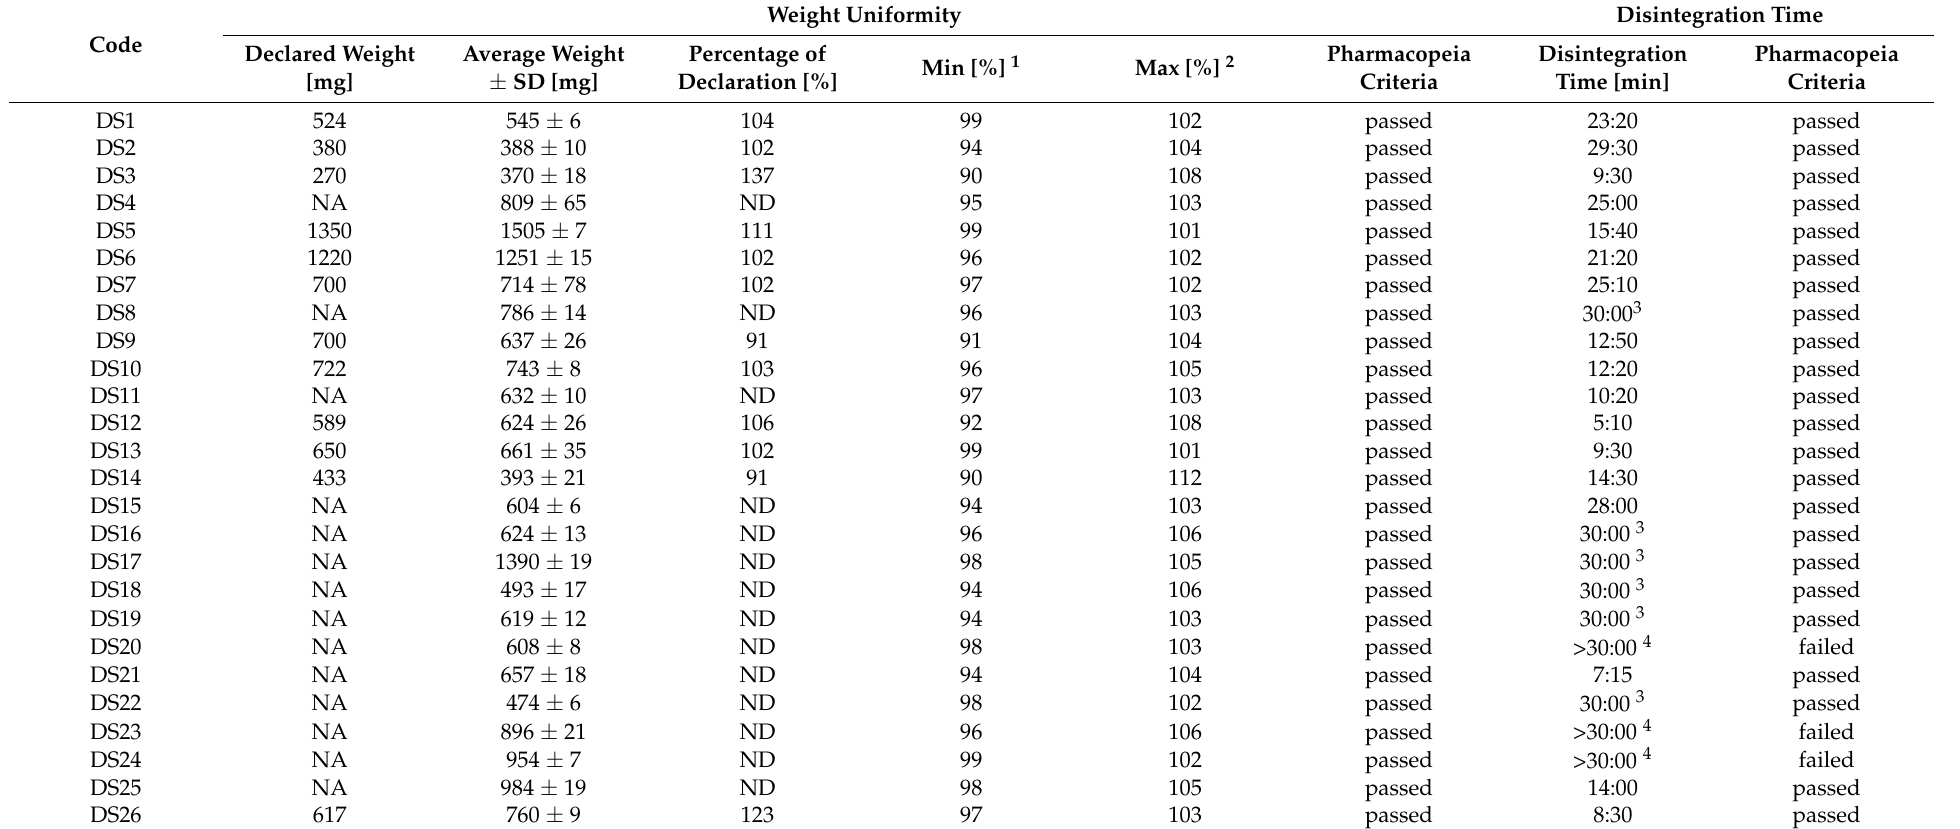
Table 2. Physical parameters of the dietary supplements in capsule